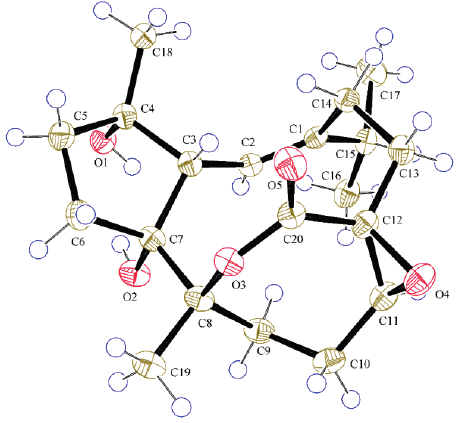
Figure 2. Key 1 H- 1 H COSY ( ▬ ) and HMBC ( → ) correlations for 1 , 2 , and 4 .